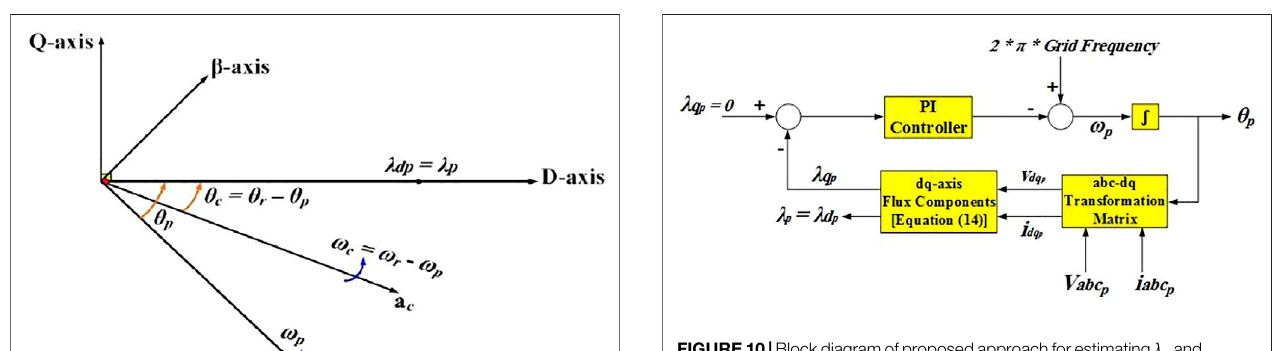
FIGURE10| Blockdiagramofproposedapproachforestimating λ p and θ p